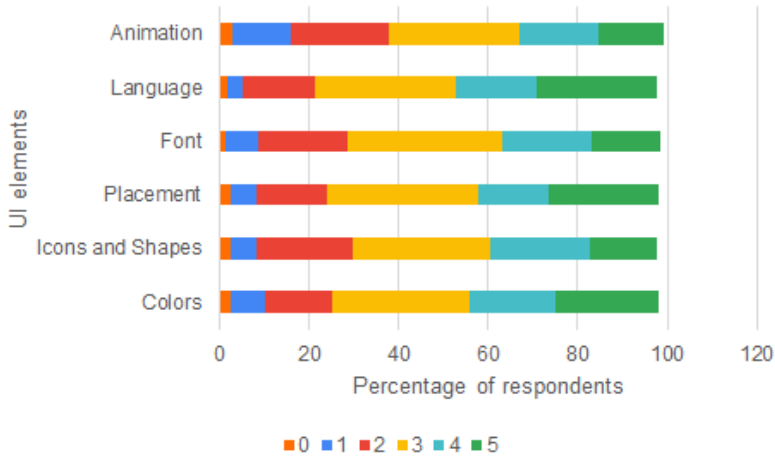
Figure 4. UI elements